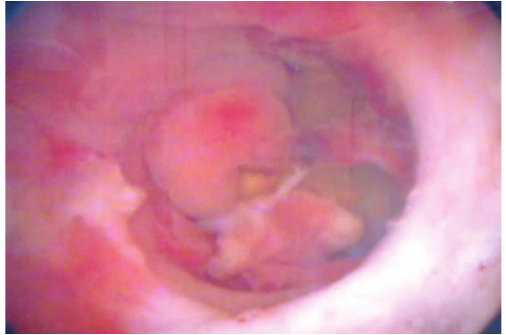
Figure 4: Postoperative cystoscopy with no